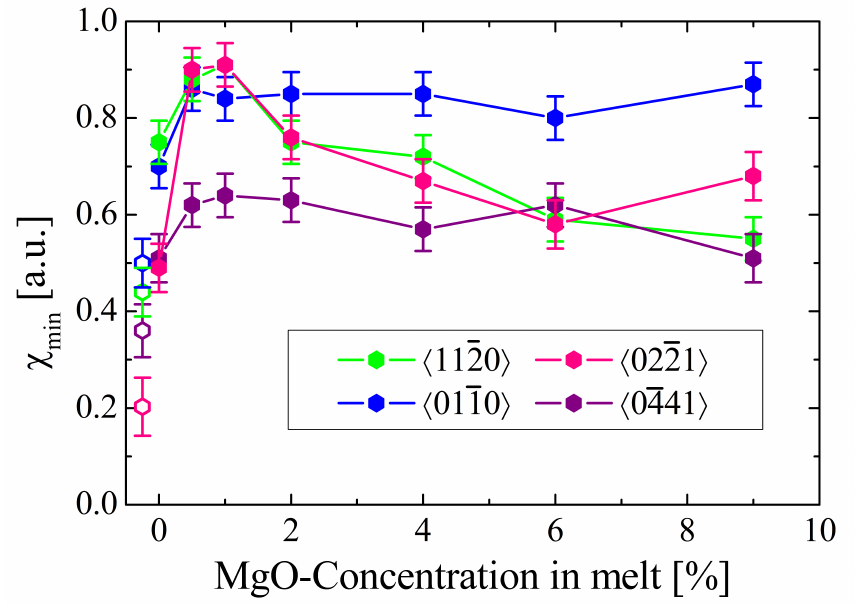
Figure 4. Dependence of the minimum yield for the 7 Li(p, α ) 4 He reaction in various axial directions in dependence of the MgO concentration (full symbols). Values for 02¯21 taken from [28]; values for from this work. The open symbols represent values for undoped ⟨ ⟩ near-stoichiometric material taken from [30,31] and are slightly shifted to the left for better visibility.